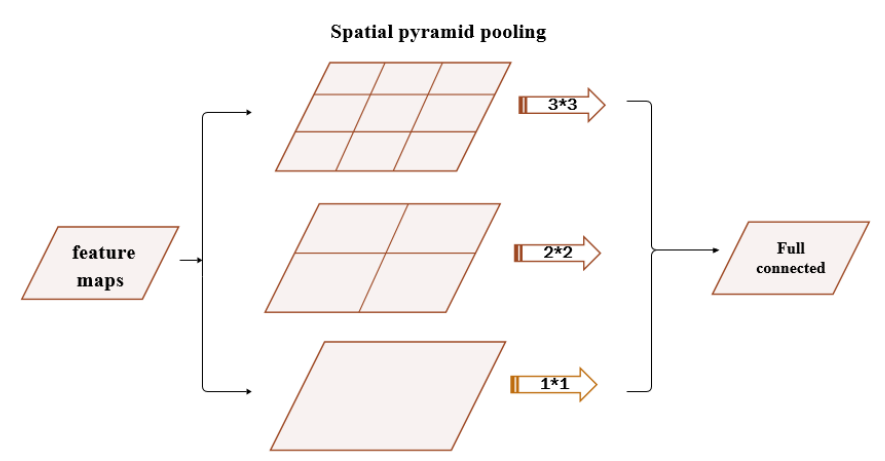
Figure 5. A network structure with a spatial pyramid pooling layer